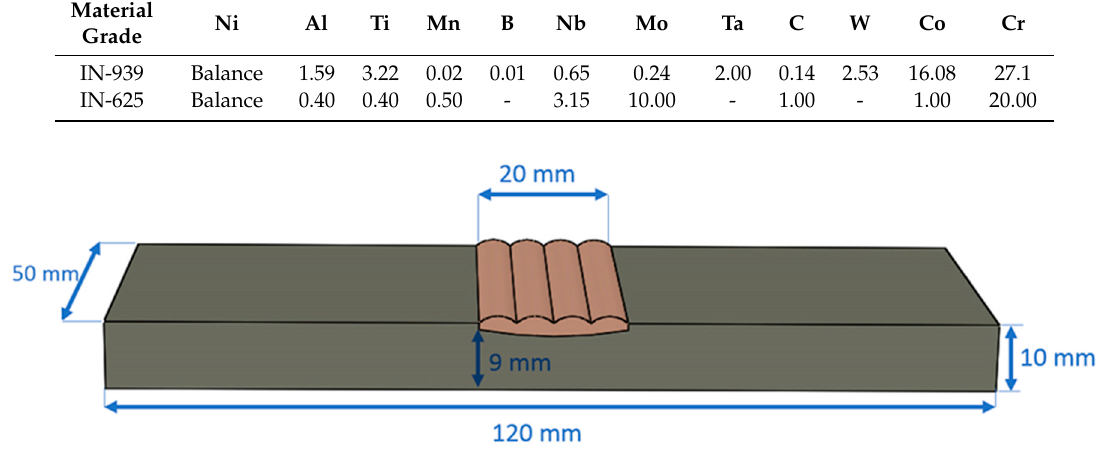
Figure 1. Schematic of the welded specimen in four side-by-side welding passes.